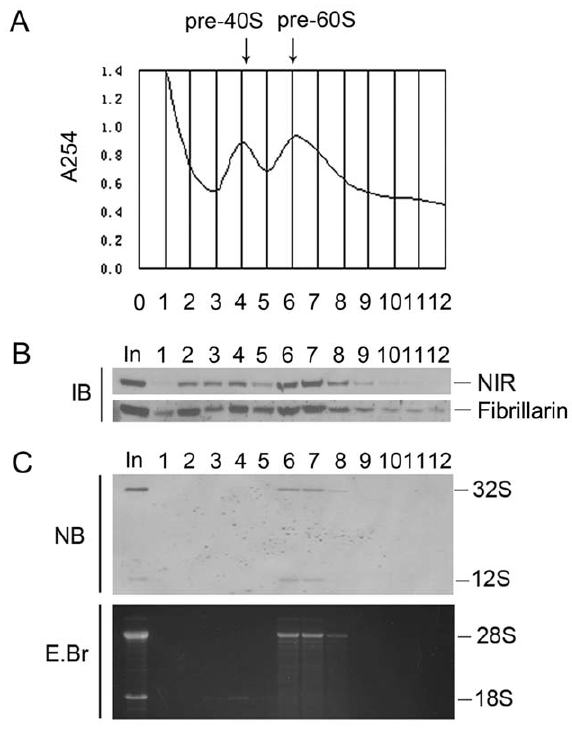
Figure 3. NIR is present in both of the 40S pre-rRNP and 60S pre-rRNP and co-sediment with 32S and 12S rRNA precursors in the nucleolus. A. Nuclear extracts were prepared from U2OS cells and fractionized on 10% to 40% sucrose density gradient. The absorbance at 254 nm (A 254 ) of each fraction was profiled and the position of pre-ribosomal subunits was indicated. B. Proteins from fractions described in A were separated on a SDS-PAGE and subjected to immunoblotting analysis using anti-NIR antibody. Fibrillarin was probed as a control. C. RNA from each fraction was resolved on a 1% agarose-glyoxal gel and transferred onto nylon membrane after stained with EB (lower panel). Blot was probed with biotin-labeled ITS-2 oligonucleotide (upper panel). In, un-fractionized nuclear extract.